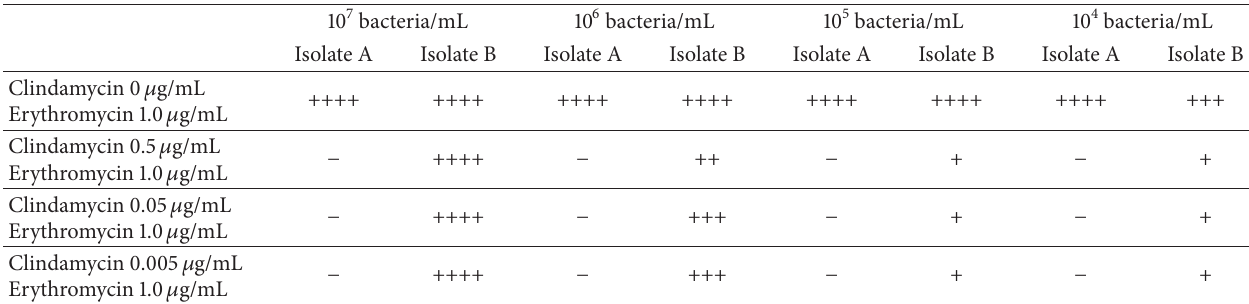
Table 1: Detection of GBS following 9-hour incubation in the presence of erythromycin and dilutions of clindamycin. Isolate A (noninducible resistance to clindamycin) compared with isolate B (inducible resistance capable). ++++ OD > 3.0. +++ OD 2.0–2.9. ++ OD 1.0–1.9. +